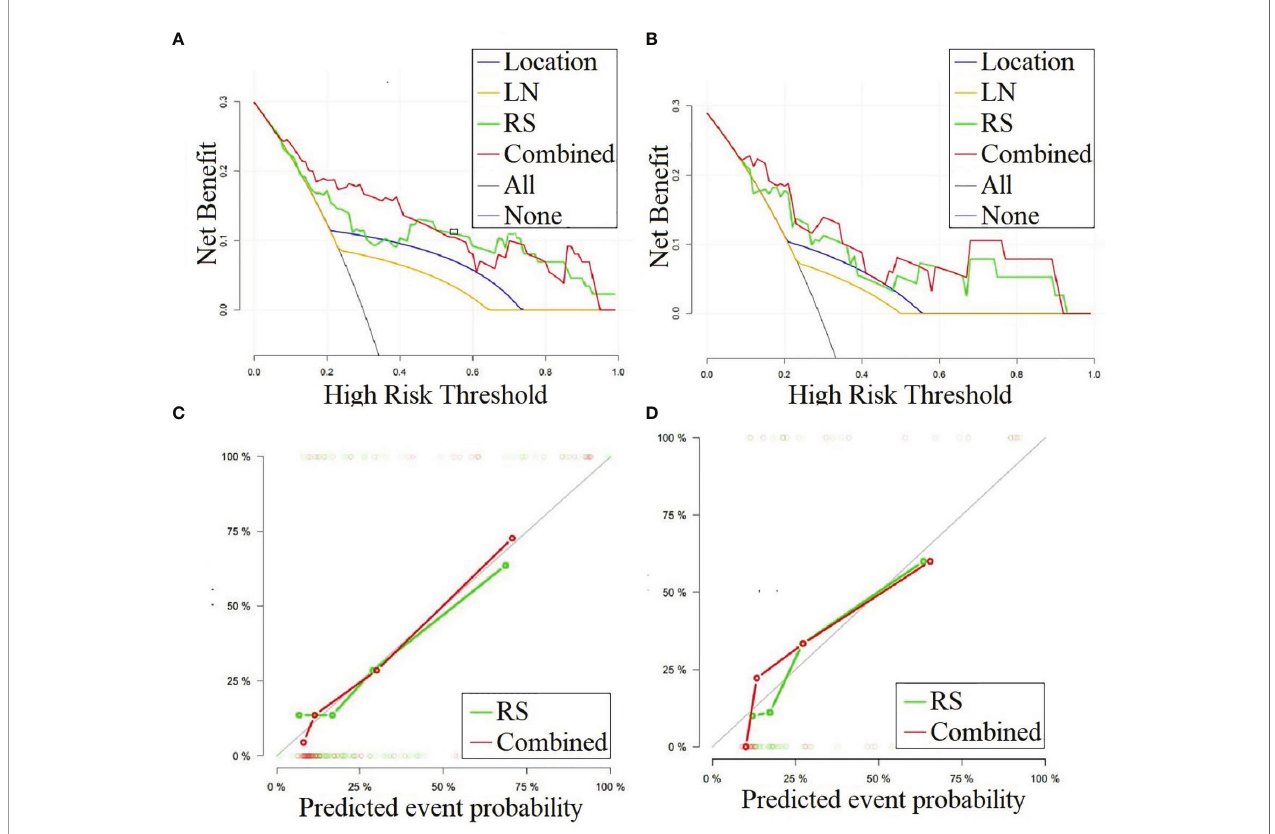
FIGURE 6 | (A, B) DCA curves for the combined model, radiomics signature, lymphadenopathy and location in classifying parotid gland tumors in the training and test sets, respectively. The graphs show that the combined model has the greatest net bene fi t for both datasets. (C, D) Calibration curves for the combined model and radiomics signature in classifying the parotid gland tumors in the training and test sets, respectively. LN, Lymphadenopathy; RS, radiomic signature.